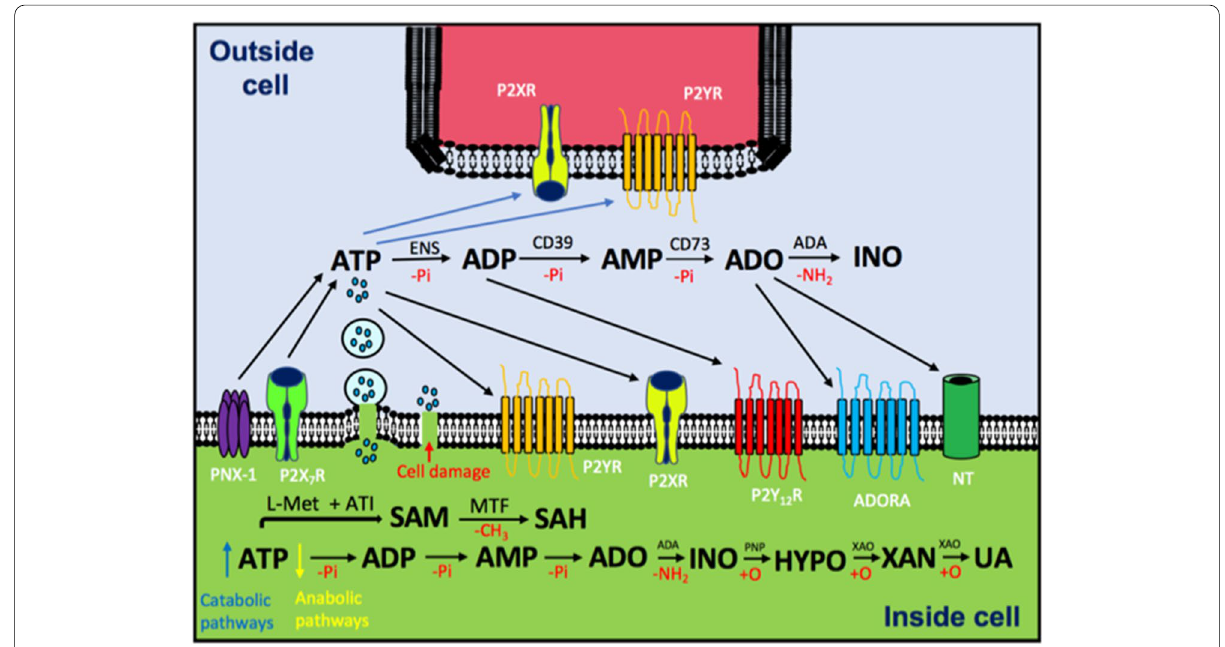
Fig. 2 Schematic representation of purinergic communication and metabolism. ATP levels inside the cells are reduced by anabolic pathways or (depending on energy charge) incremented by catabolic pathways (e.g. glycolysis and oxidative phosphorylation in the mitochondria), such ATP is released to the extracellular space by exocytosis, transporters, hemichannels, pannexin‑1 (PNX‑1), P2X 7 R or simple cell membrane disruption due to cell damage (e.g. caused by cancer) In the extracellular space, ATP stimulates P2XR (ligand‑activated ion channels), P2YR (G‑protein coupled receptors) or it can be hydrolyzed, which means one inorganic phosphate less (‑Pi), by CD39 and CD73 (ecto‑nucleotidases, ENS) to ADP, AMP and ADO. In particular, ADP stimulates P2Y 12 R and ADO modulates ADORAs. The nucleoside can be deaminated by adenosine deaminase (ADA) to produce inosine (INO) or introduced into the cell by nucleoside transporter (NT). Within the cell, SAM is synthetized from L‑methionine and ATP by a reaction catalyzed by adenosyl transferase isoenzymes (ATI) and with the help of Methyl Transferases (MTF) it is converted to SAH. The catabolism of ADO goes from deamination (to obtain inosine) catalyzed by ADA to consecutive oxidations ( O) to obtain hypoxanthine (HYPO) (reaction + catalyzed by purine‑nucleoside phosphorylase, PNP), Xanthine (XAN) and finally Uric Acid (UA), both reactions catalyzed by xanthine oxidase